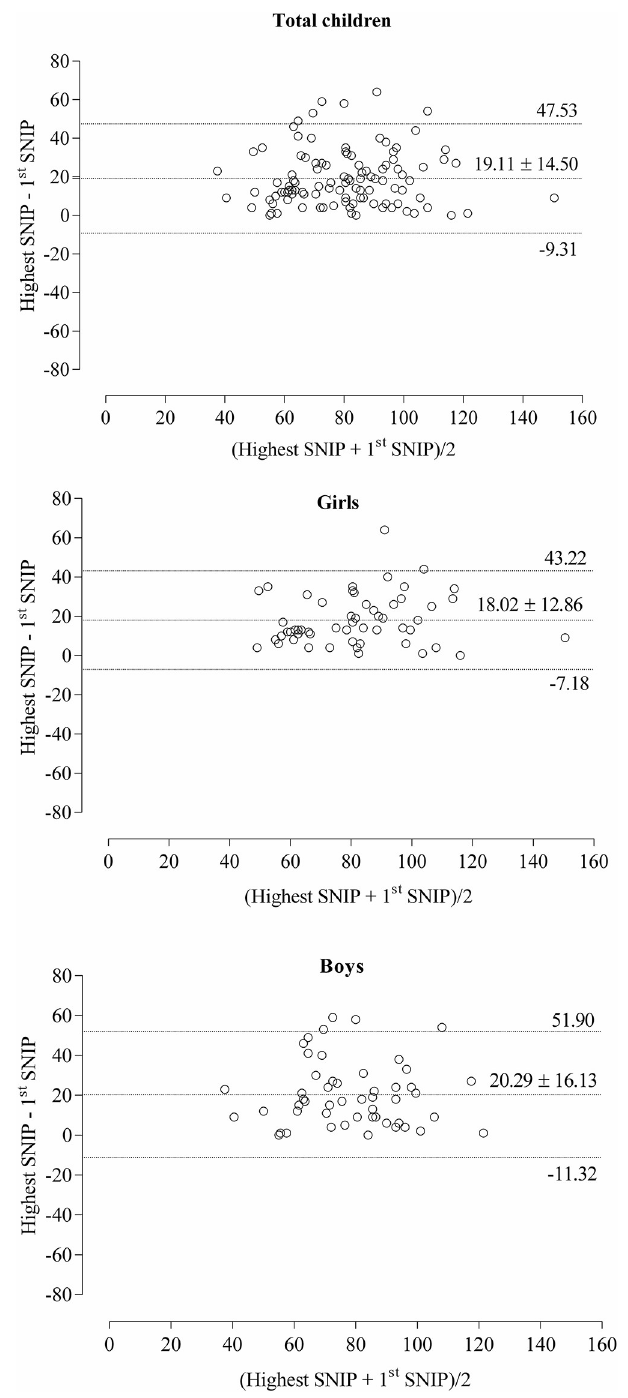
Fig 1. Bland-Altman showing agreement between the highest SNIP (cmH 2 O) and the 1 st acceptable maneuver of total children and stratified by sex the middle line shows the mean difference. The upper and lower limits of agreement represent 1.96 standard deviations above and below the mean